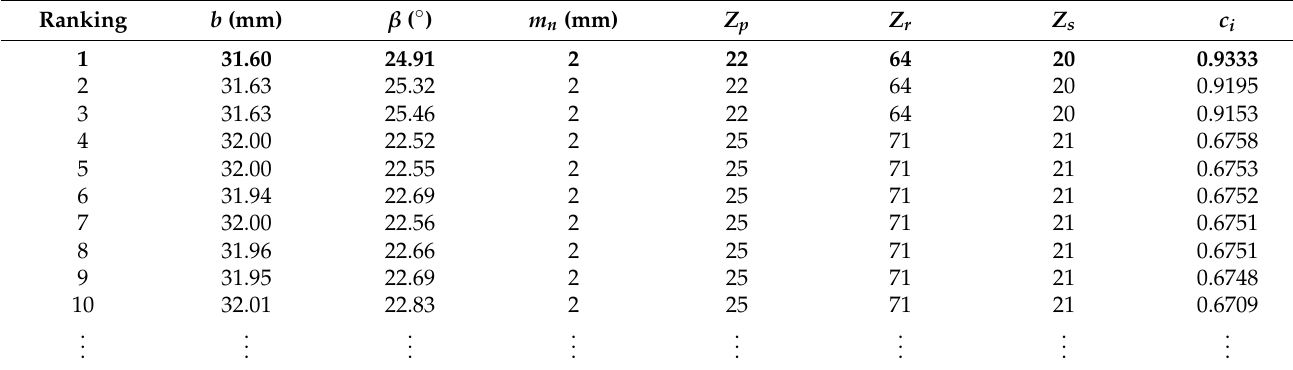
Table A1. Optimization results from MDOD.